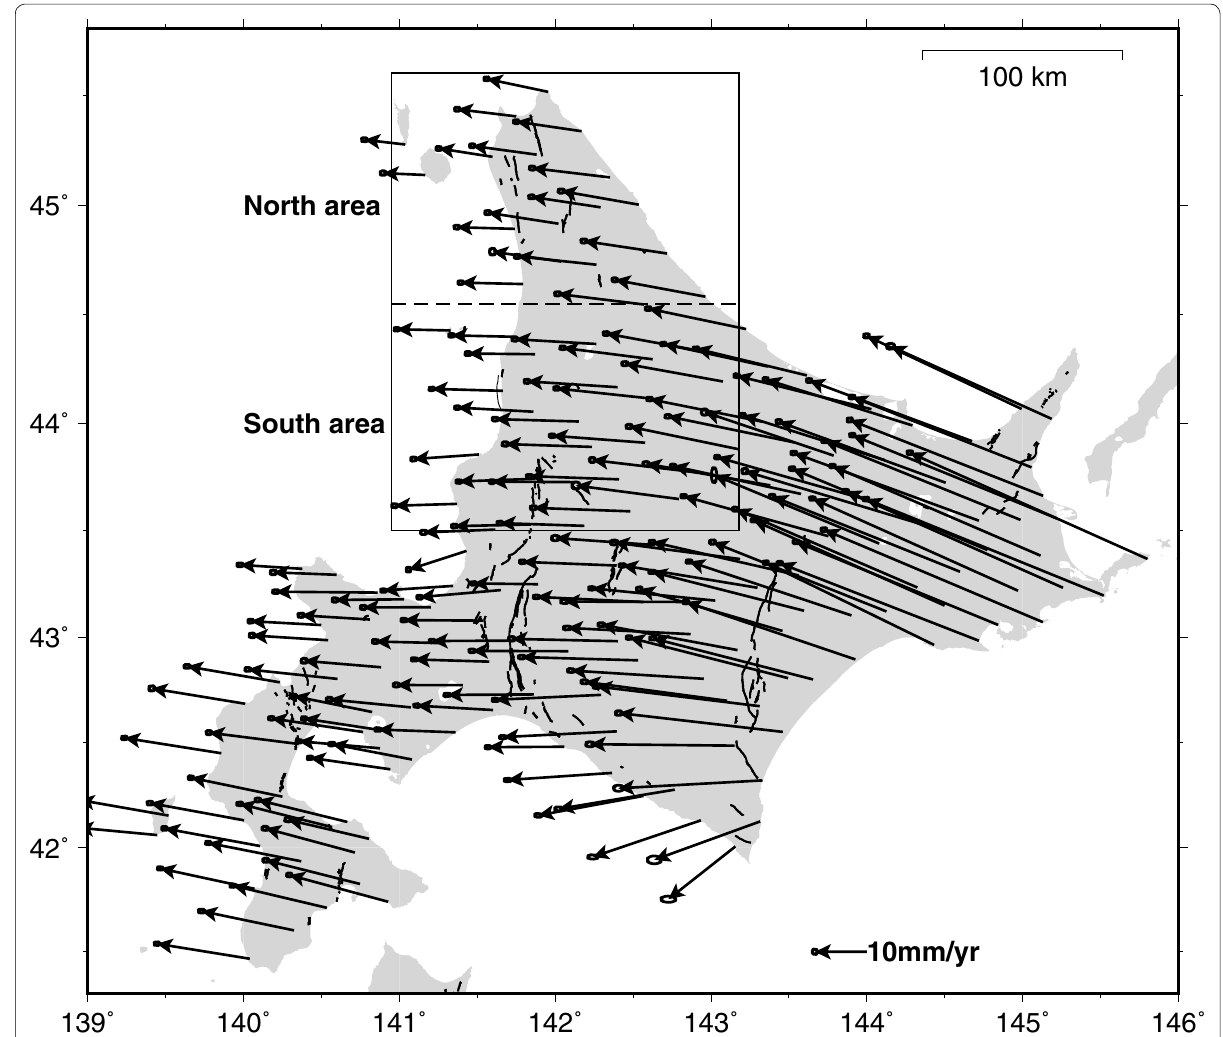
Fig. 2 Observed horizontal velocity field with respect to the Eurasian plate from 2008 to 2010. The error ellipse indicates 2 σ . The rectangle delineated by a solid black line indicates the area of analysis that includes 44 GNSS stations (whole area). The dashed black line separates the analysis area into a northern (17 stations) and a southern (27 stations) part. Solid black lines represent active faults (Nakata and Imaizumi